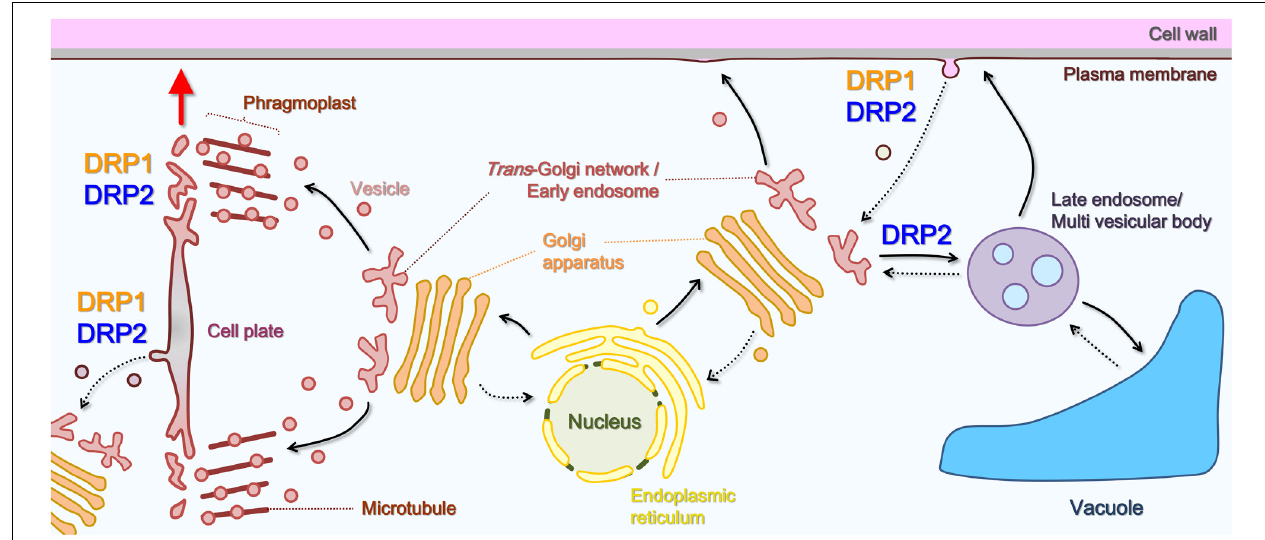
FIGURE 3 | Schematic illustration of the roles of DRP1 and DRP2 in post-Golgi trafficking pathways. Solid black arrows, secretory or vacuolar pathways; dotted black arrows, endocytic or retrograde pathway; red arrow, direction of cell plate expansion.